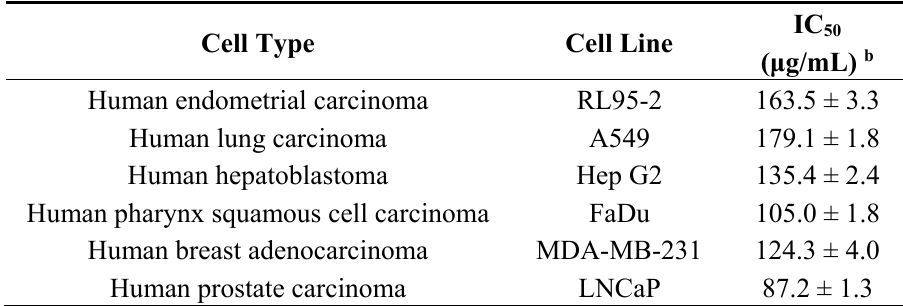
Table 1. Cytotoxity of SOE on various cancer cell lines a